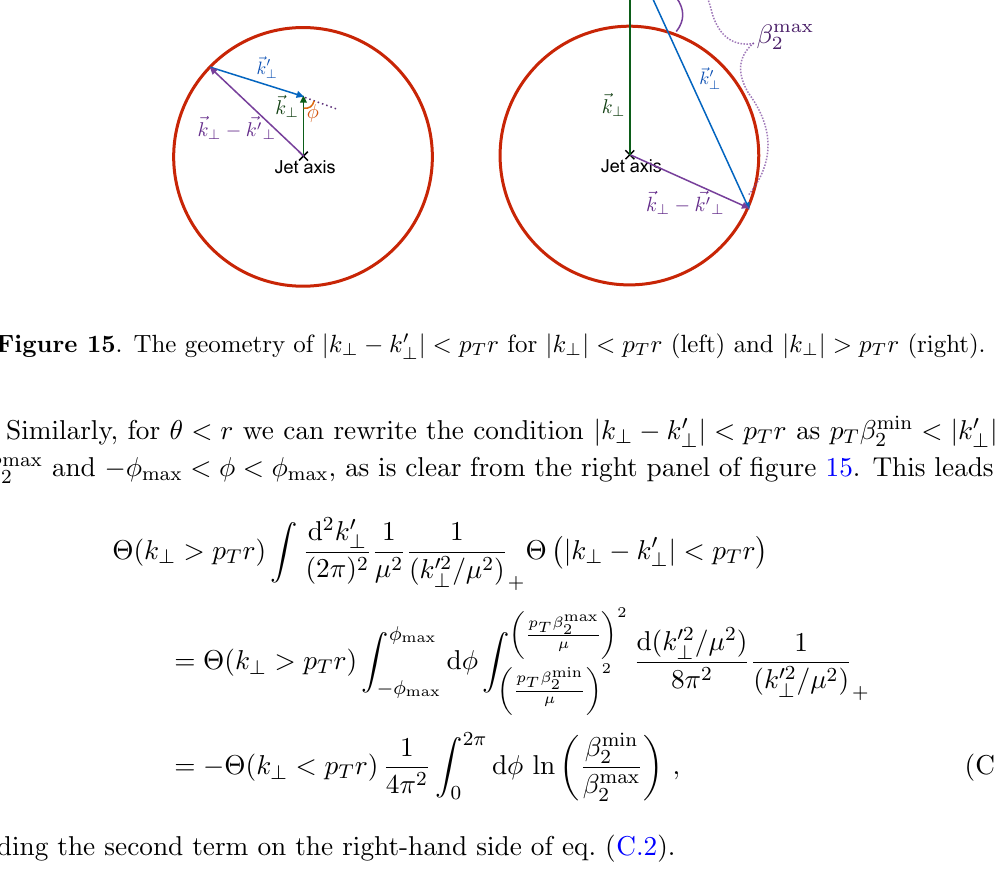
Figure 15 . The geometry of